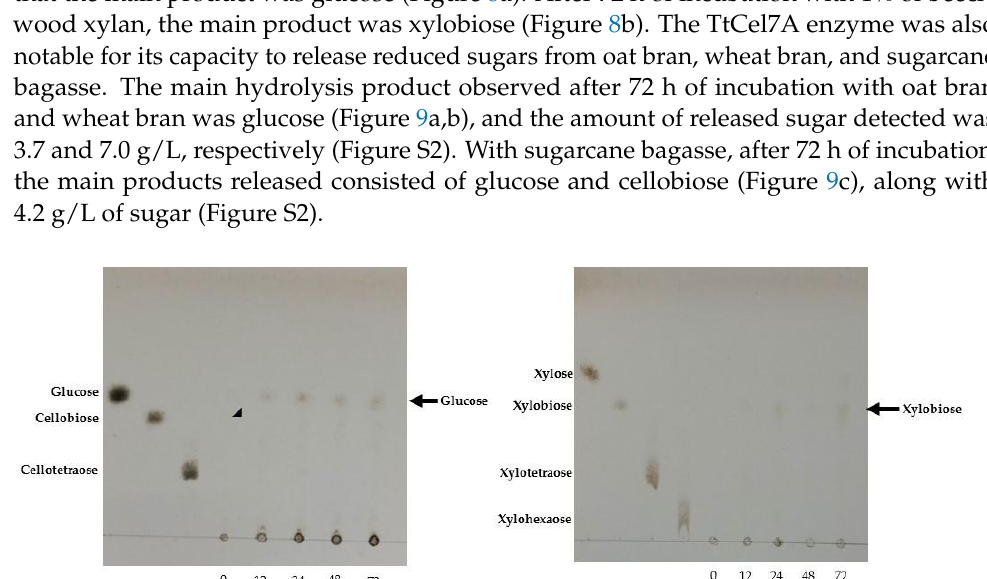
Figure 7. Effect of metal ions, EDTA, and 2-ME on cellulase and xylanase activity of TtCel7A. Activ- ity was measured at 1 mM concentration and incubated in 0.6% ( w / v ) CMC and xylan in 50 mM acetate buffer, pH 5.5. The activity observed without any element was used as a control and consid- ered 100%.